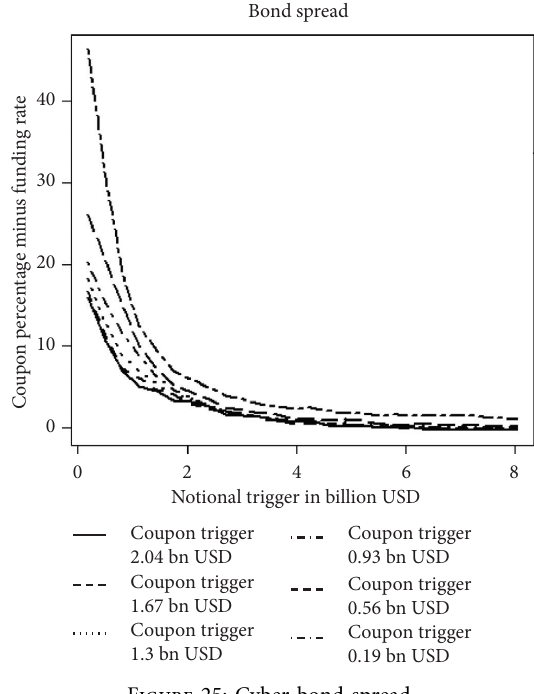
Figure 25: Cyber bond spread.